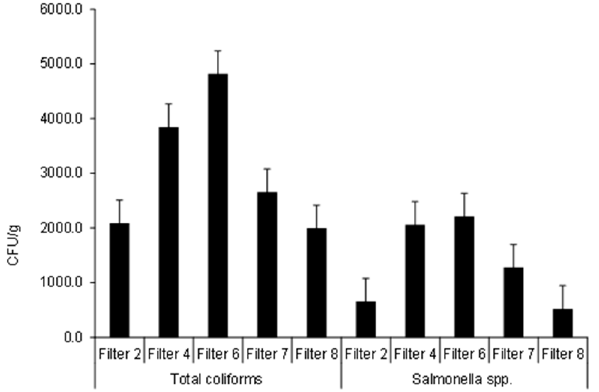
Figure. 3. Soil microbial content. Figure 3. Soil microbial